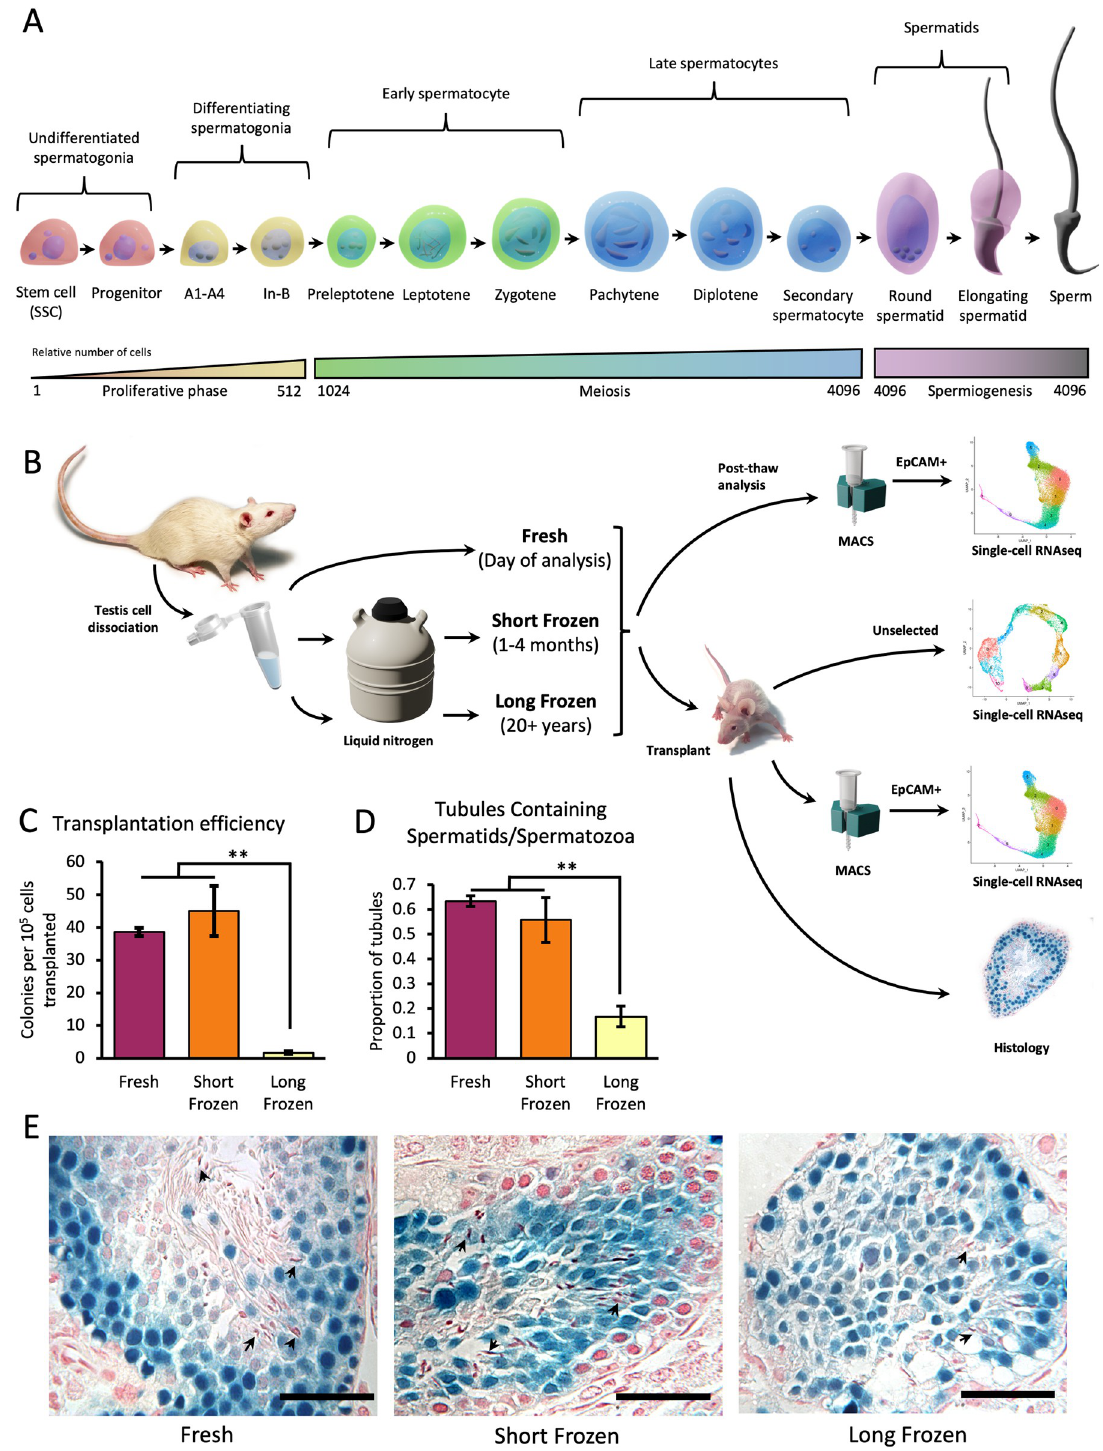
Fig 1. Transplantation of cryopreserved rat germ cells reconstitute spermatogenesis in the mouse. (A) Summary of spermatogenesis. Stem cells are the founders of spermatogenesis and differentiate into proliferating progenitor spermatogonia. Differentiating spermatogonia are comprised of A1 to A4 spermatogonia, intermediate (In) and B spermatogonia. Preleptotene, leptotene, and zygotene are grouped as early spermatocytes, while pachytene, diplotene, and secondary spermatocytes are classified as late spermatocytes. Finally, round and elongating spermatids precede fully formed sperm. Ideal numbers of cells are shown given the number of cell divisions from a